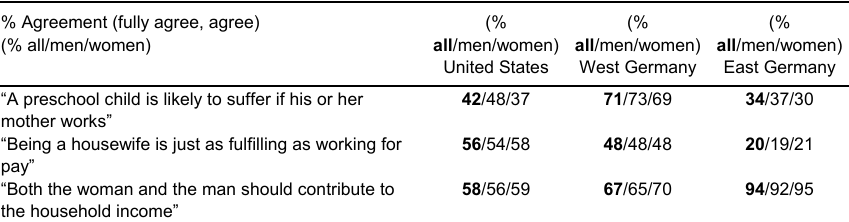
Table 3 Comparison of Cultural Attitudes Towards Work and Family in the United States, West and East